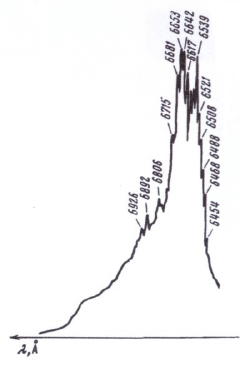
Figure 4. Fluorescence spectrum of chlorophyll “b” in n-undecane at 4.2 K. (Personov et al. 1974).